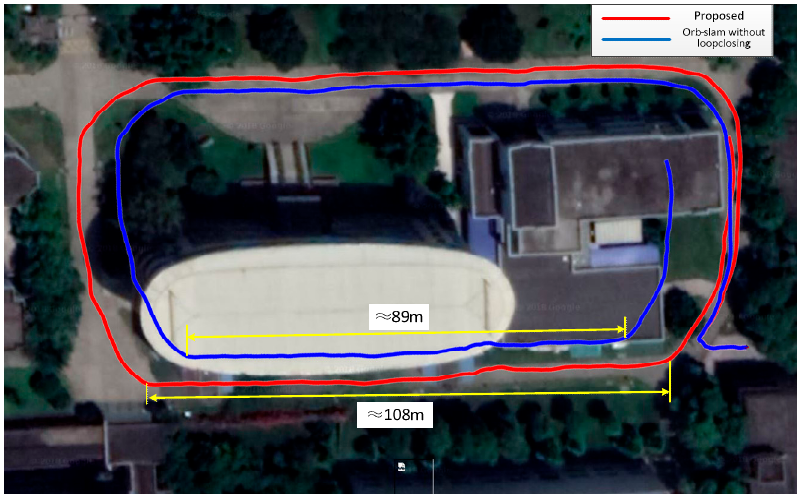
Figure 8. Comparison of the measurement trajectory projections for the proposed method and the Monocular ORB-SLAM method.